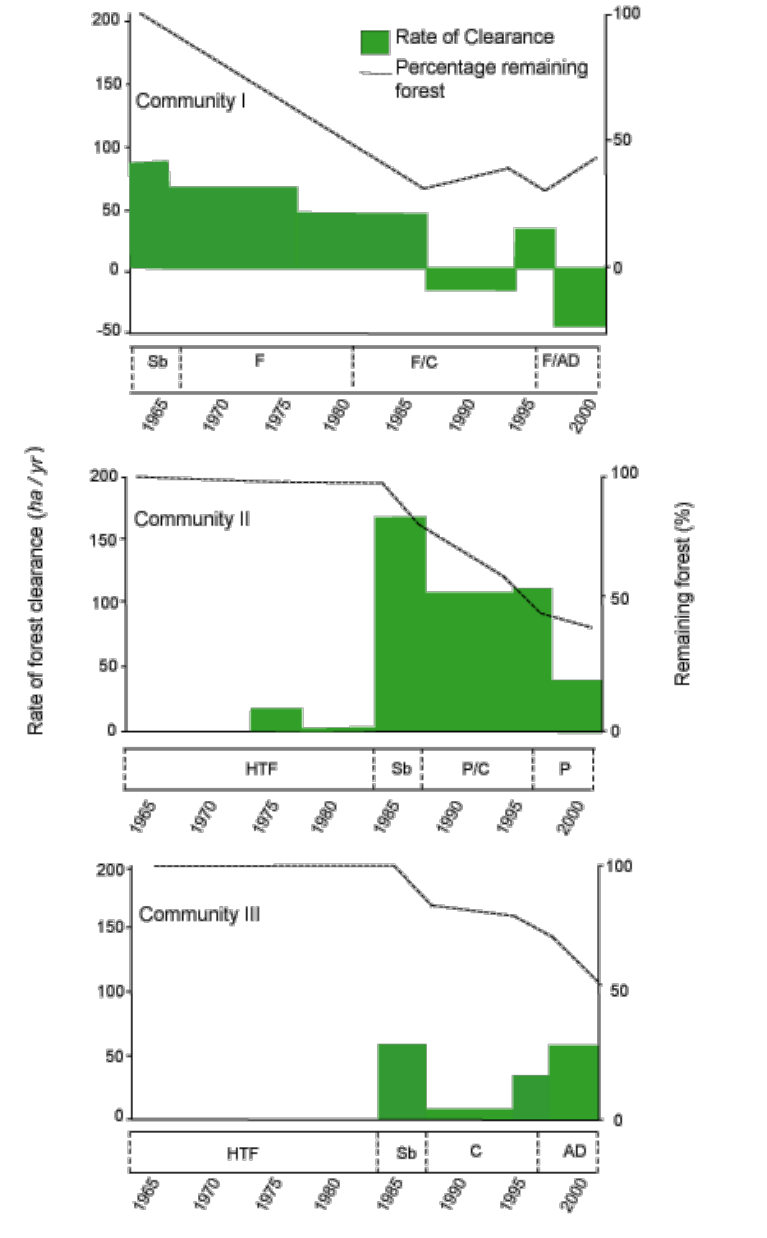
Fig. 2. Inter-image forest clearance rates (histograms) in ha/yr and proportions of forest remaining (line graphs) for Community I (top), Community II (middle), and Community III (bottom) between 1963 and 2000. The dominant land management tendencies are given for each community: HTF–humid tropical forest (no cultivation); Sb–subsistence; C–coca; AD–alternative development programs (substitute crops); R–rice; P–pasture;